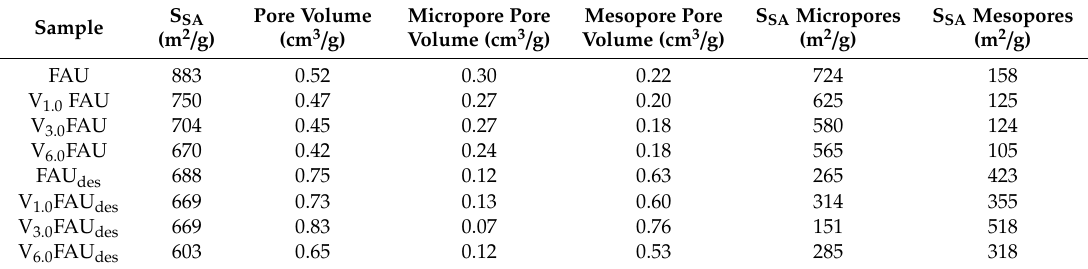
Table 2 gathers data obtained from the porosimetric studies. Table 2. N 2 physisorption-derived parameters characterizing the obtained samples (S SA – specific surface area).